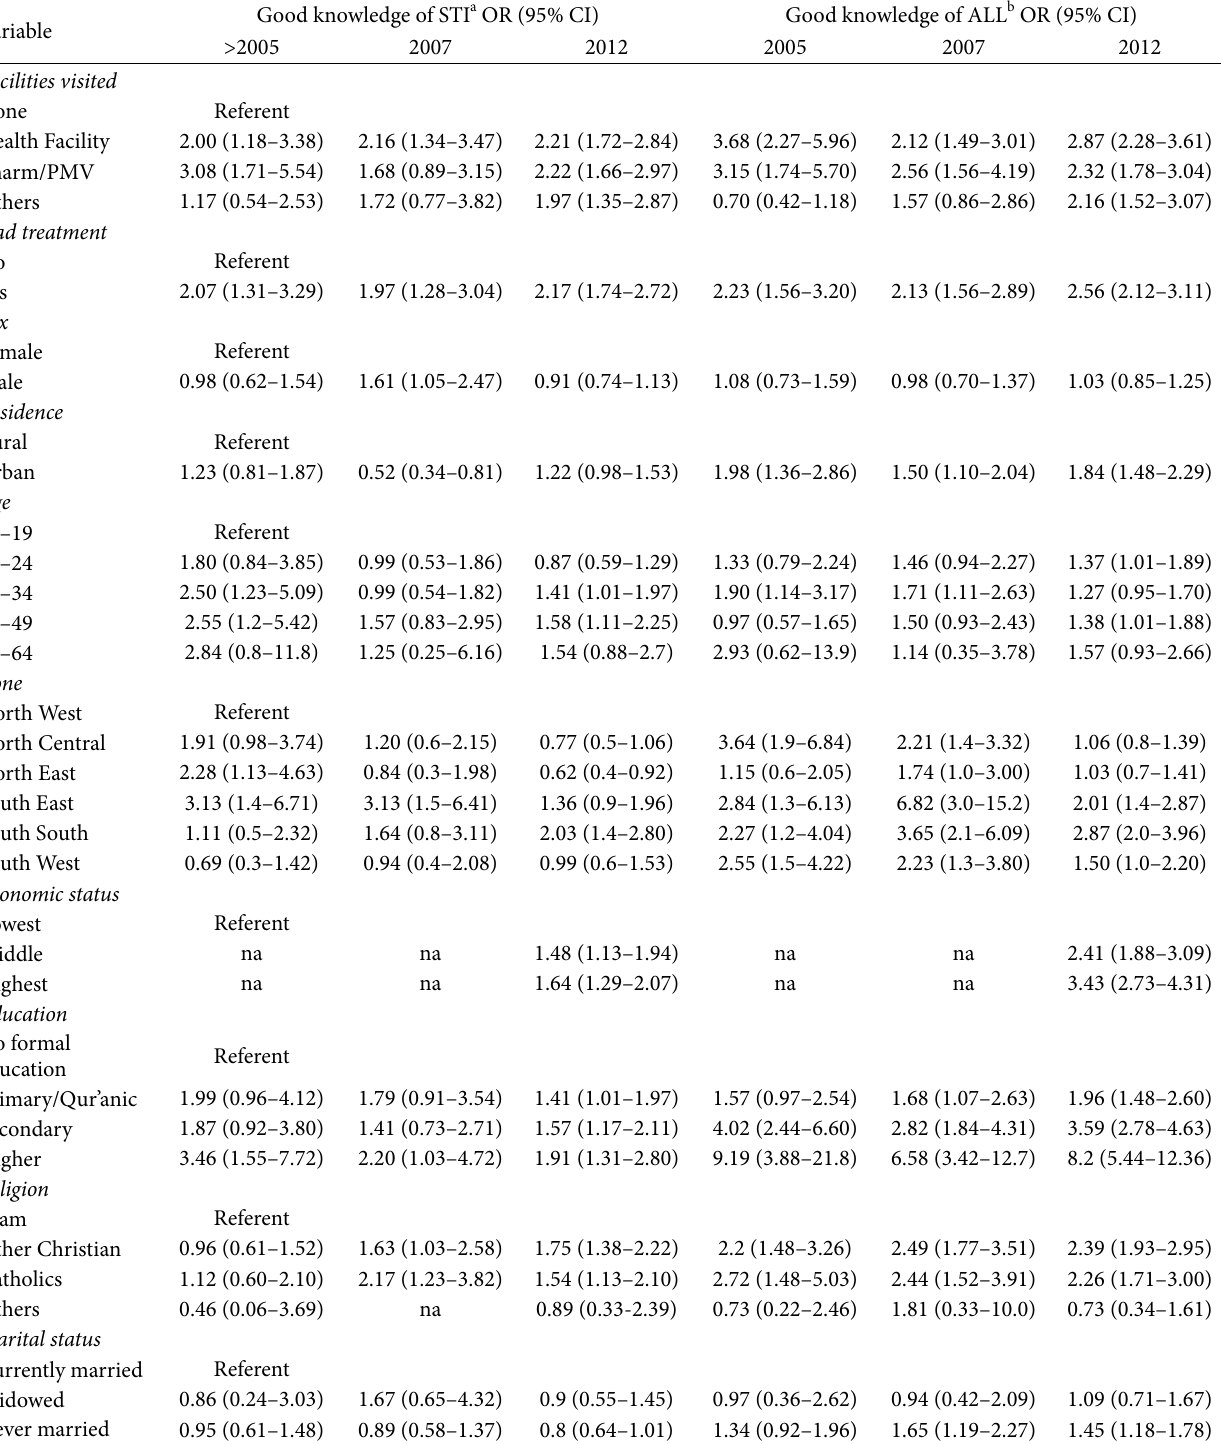
Table 5: Bivariate logistic regression of factors affecting knowledge of STI and other related